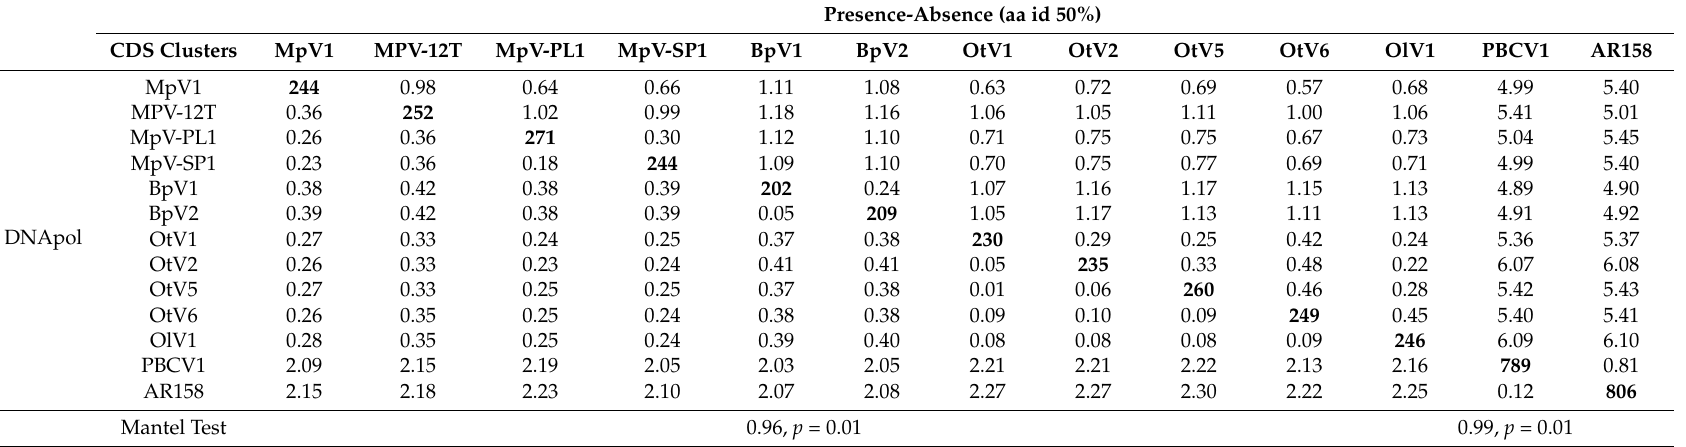
Table 3. Phylogenetic distance between pairs of reference viruses based on full length DNApol and gene presence or